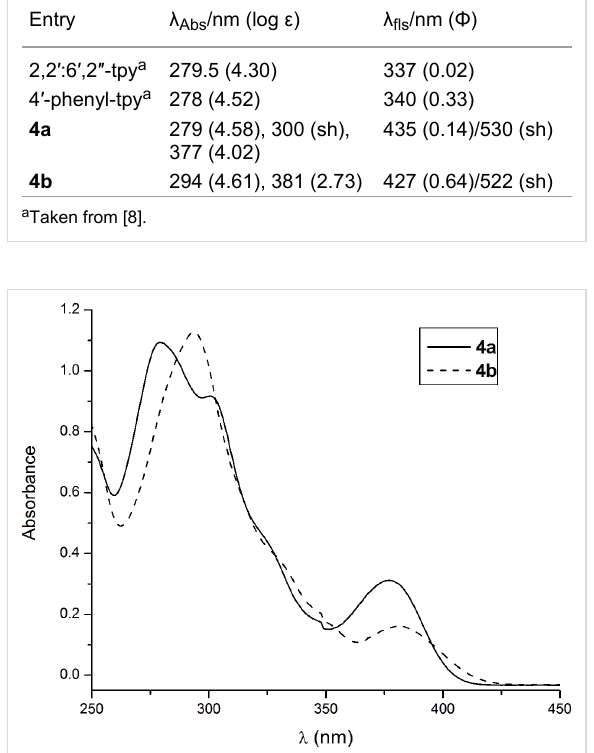
The results of TDDFT calculations showed that the longest wavelength absorption maximum originates from a π – π transi- tion centered on the azulene moiety but having some azulene → central pyridine charge transfer as electrons from HOMO and LUMO+1 orbitals (Figure 6) are involved. The HOMO (orbitals 94 and 107 for 4a and 4b respectively in Figure 6) is localized only over azulene moiety, while the LUMO+1 (orbitals 96, 108 for 4a and 4b , respectively) is an orbital delocalized over the azulene moiety and the central pyri- dine ring. On the other hand both DFT calculated (vide infra) and X-ray structures show that the azulene moiety is twisted from the central pyridine ring to a greater extent in 4b . It becomes clear that the substitution on the azulene moiety tends to break the azulene/central pyridine planarity and possibly reduce the azulene → central pyridine charge transfer effect, hence affecting the absorption maximum. Both compounds showed fluorescent emission upon excitation at wavelengths corresponding to their absorption maximum.